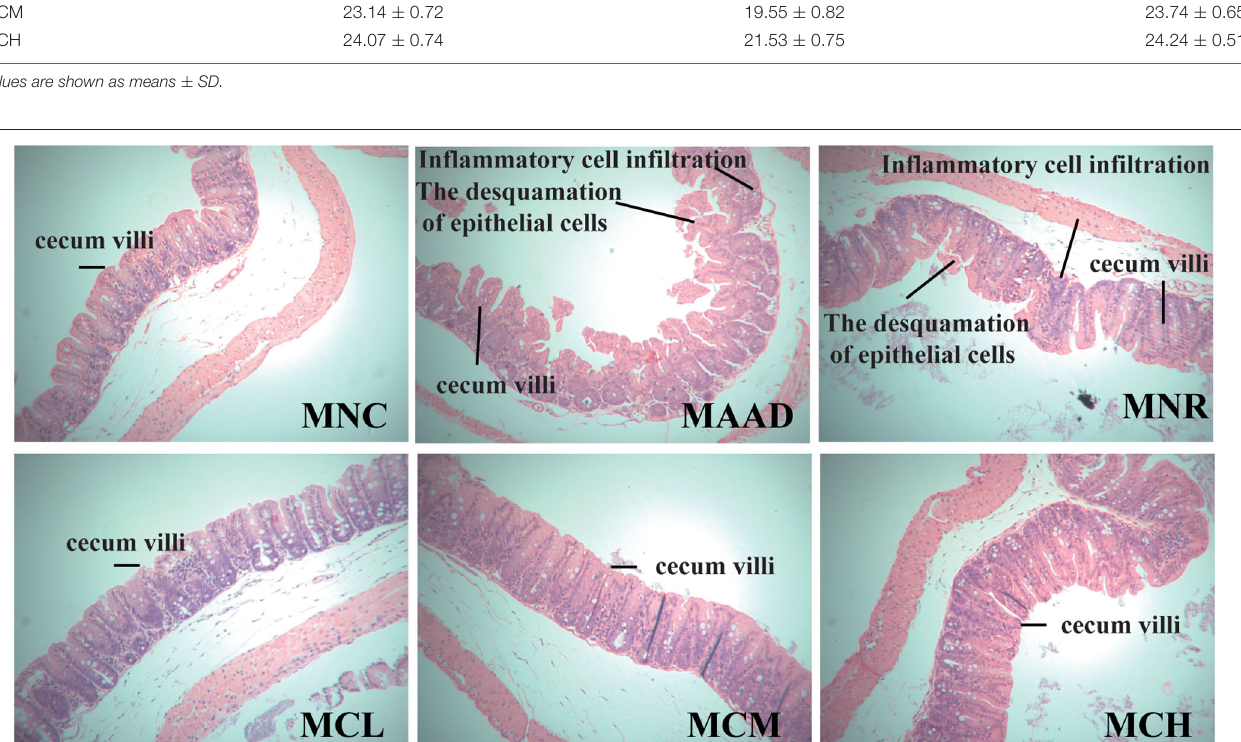
in terms of the production of acetate, propionate, butyrate and total